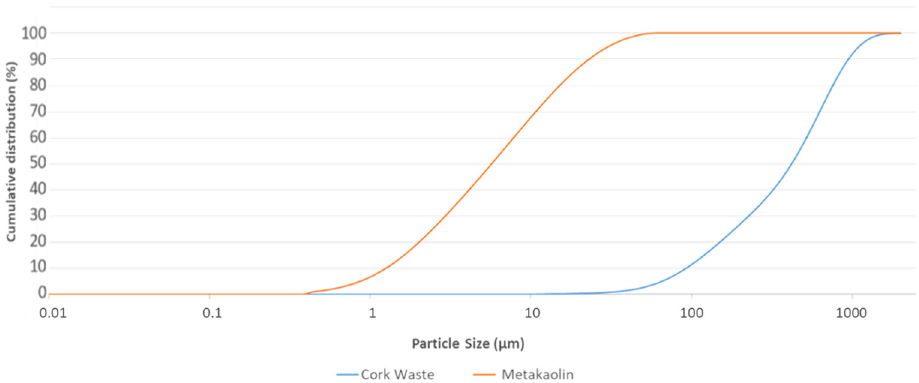
Figure 1. Comparison of particle size cumulative distribution curves of pure metakaolin (MK) and cork waste (CW).